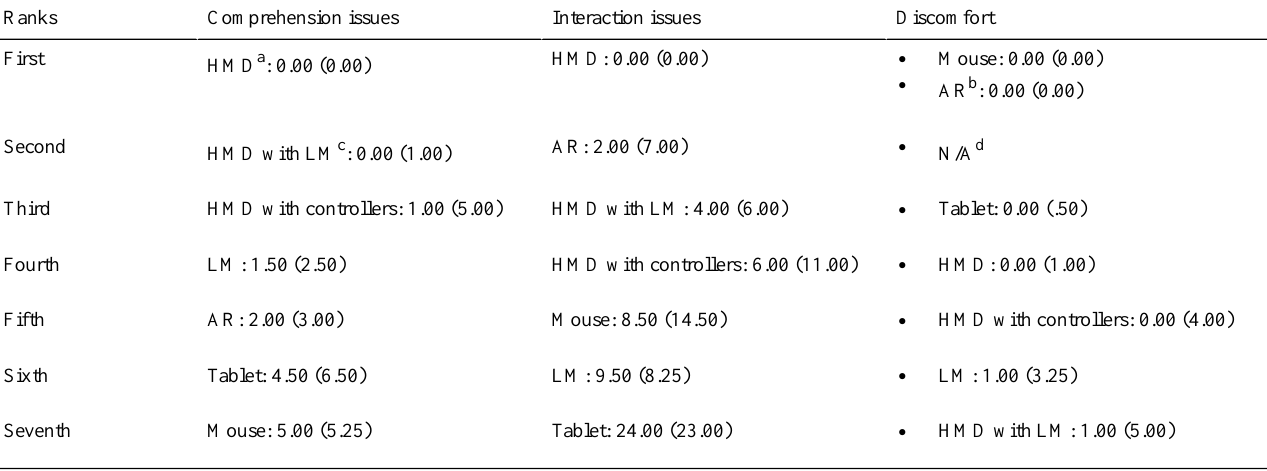
Table 2. Ranking of technologies according to performance domains.